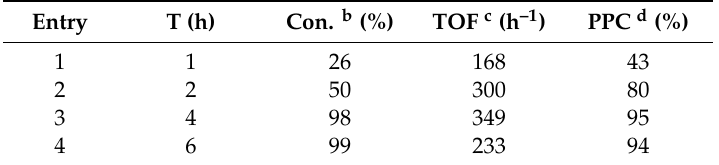
Table 4. (Salen- 4 )[Co(III)TFA] 2 / [PPN]TFA catalyzed PO / CO 2 copolymerization at different reaction times a